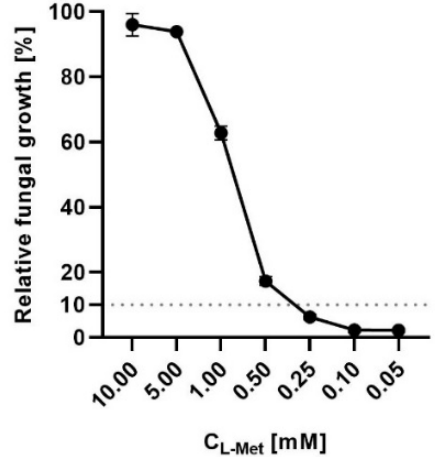
Figure 9. Inhibition of C. glabrata growth by L-Pen in YNB + SA medium supplemented with L-Met (10–0.05 mM). The dotted line represents 10% cell growth, which is a borderline reduction in visible growth, considered as no growth. The error bars represent the standard deviation (SD).